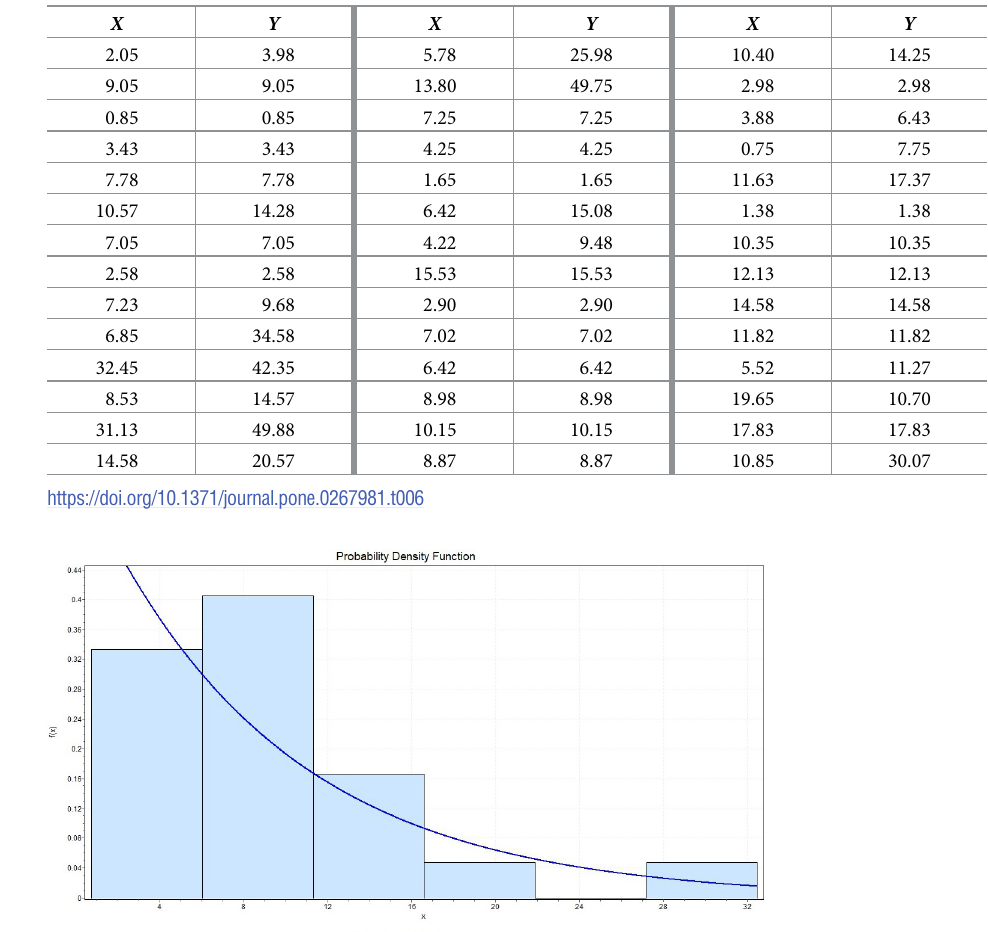
Table 6. American Football league data.